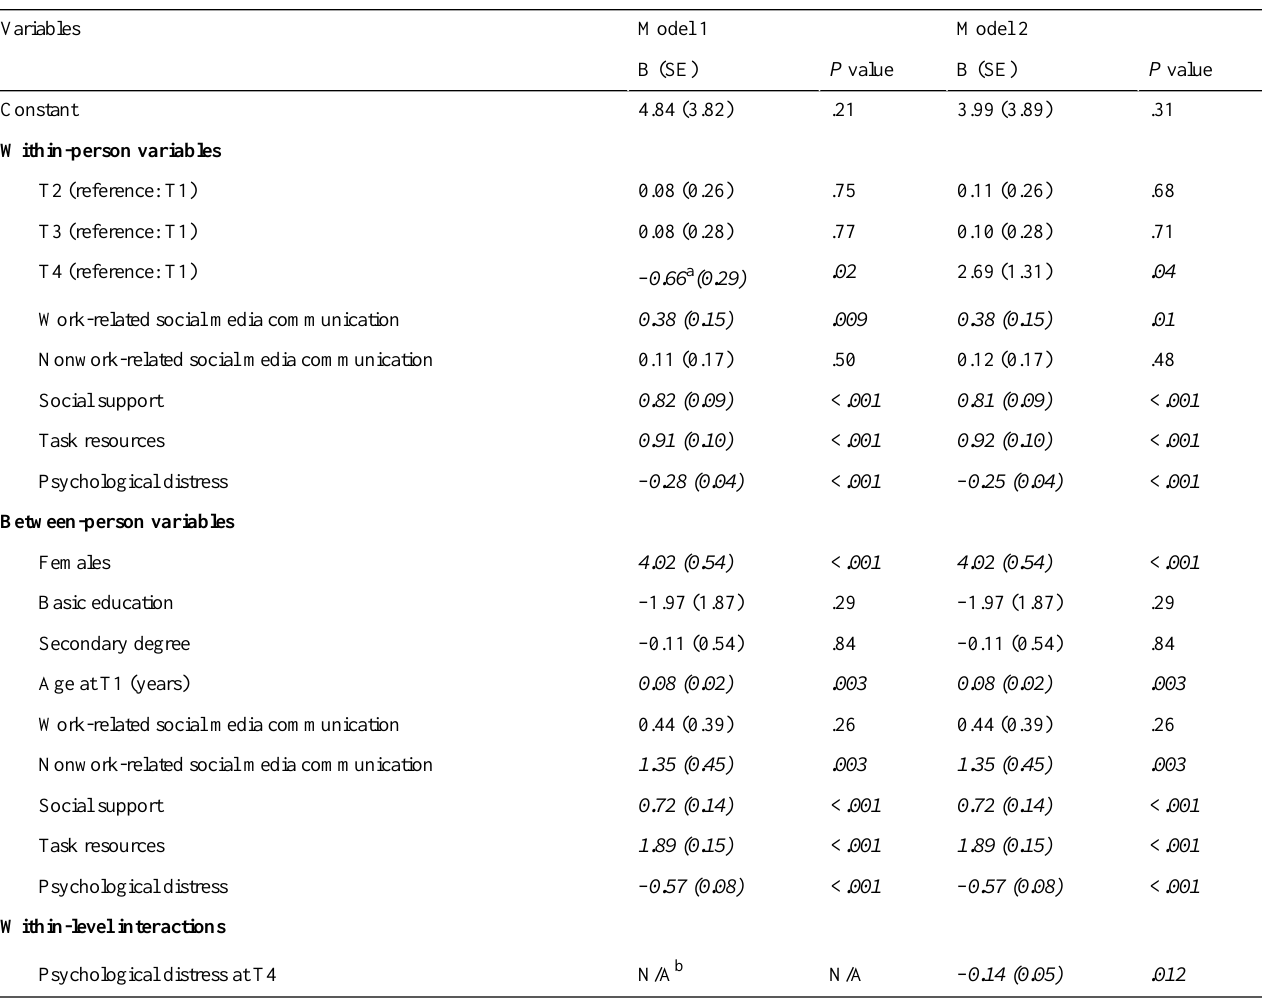
Table 3. Within-between models predicting changes in work engagement with time: fixed effects.